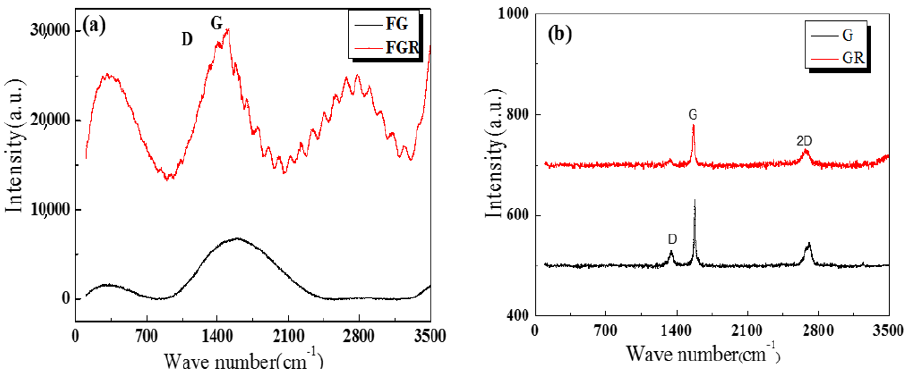
Figure 4. Raman analysis of four carbon materials. ( a ) Raman analysis of FG and FGR, ( b ) Raman analysis of G and